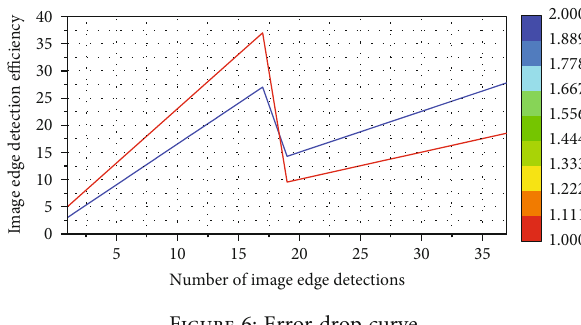
Figure 6: Error drop curve.